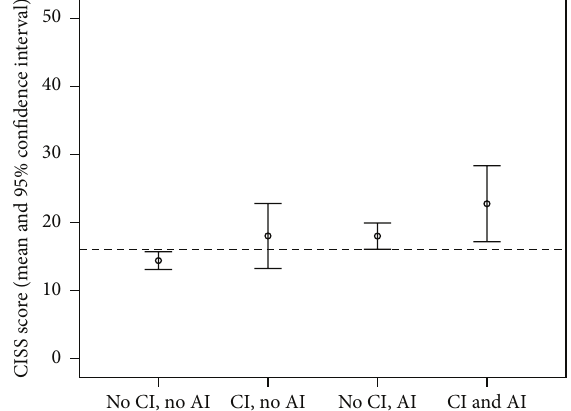
Figure 1: Mean Convergence Insufficiency Symptom Survey (CISS) score by presence/absence of clinical convergence insufficiency (CI) and clinical accommodative insufficiency (AI). Dashed line represents the CITT cutoff score for “symptomatic”